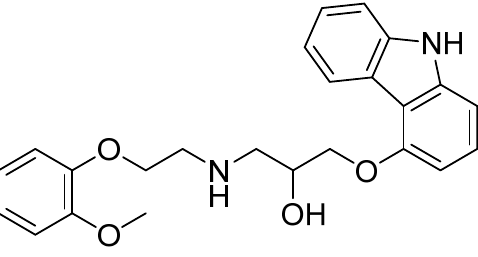
Figure 1. Chemical structure of carvedilol.